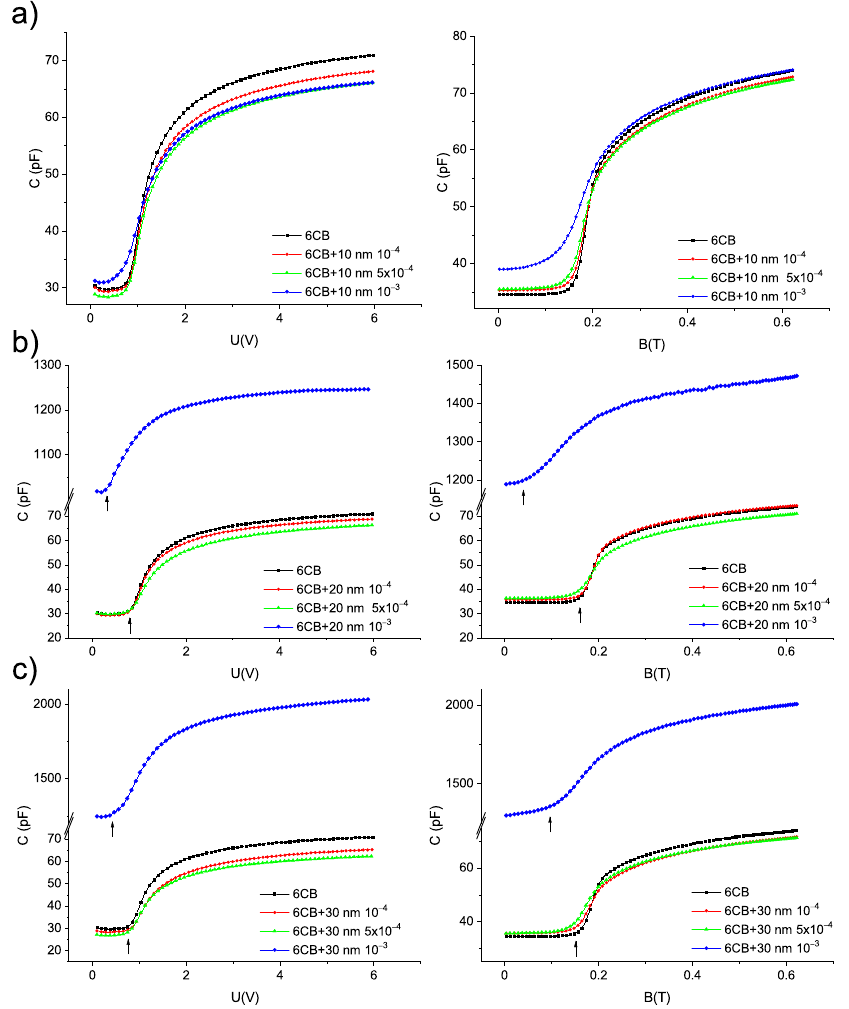
Figure 4. Dependencies of capacitance on electric and magnetic field for pure 6CB and composites containing ( a ) 10 nm ( b ) 20 nm ( c ) 30 nm